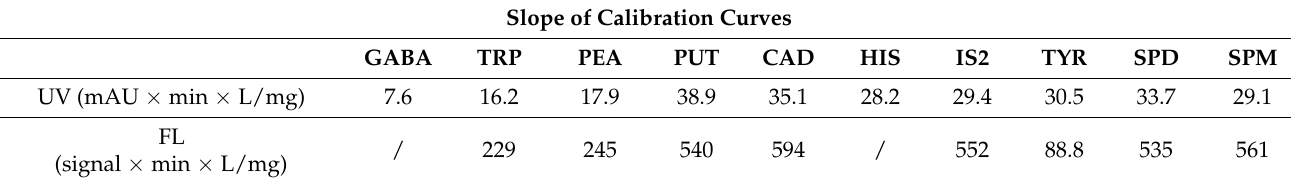
Table A1. Slope of calibration curves for biogenic amines and GABA obtained after fluorimetric and spectrophotometric detection. The concentration of biogenic amines and GABA used for the calculation of the calibration curve corresponds to the values in 250 µ L of the calibration solution (mixture of standards in 0.4 M HCl) used in derivatization experiments.